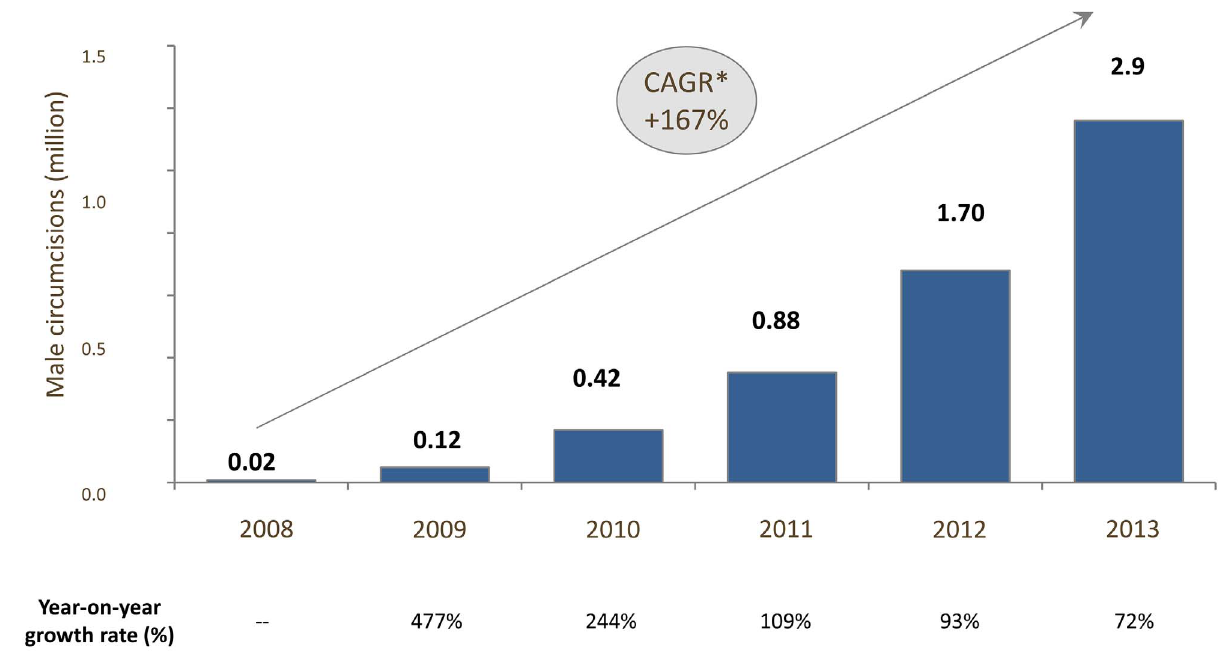
Figure 2. Scale-up of voluntary medical male circumcision program and coverage in 14 priority countries, aggregate, 2008–2013. Number of circumcisions completed each year in millions. Source of 2008–2012 data is the WHO 2012 VMMC report [38]. 2013 numbers have been estimated using data from PEPFAR and the Bill & Melinda Gates Foundation. *CAGR, compound annual growth rate, calculated based on the average proportional growth each year. CAGR (t 0 ,t n ) = (V(t n) /V(t 0 )) 1/(tn 2 to) 2 1, where V(t 0 ) is the start value and V(t n ) is the finish value and t n 2 t 0 is the number of years.